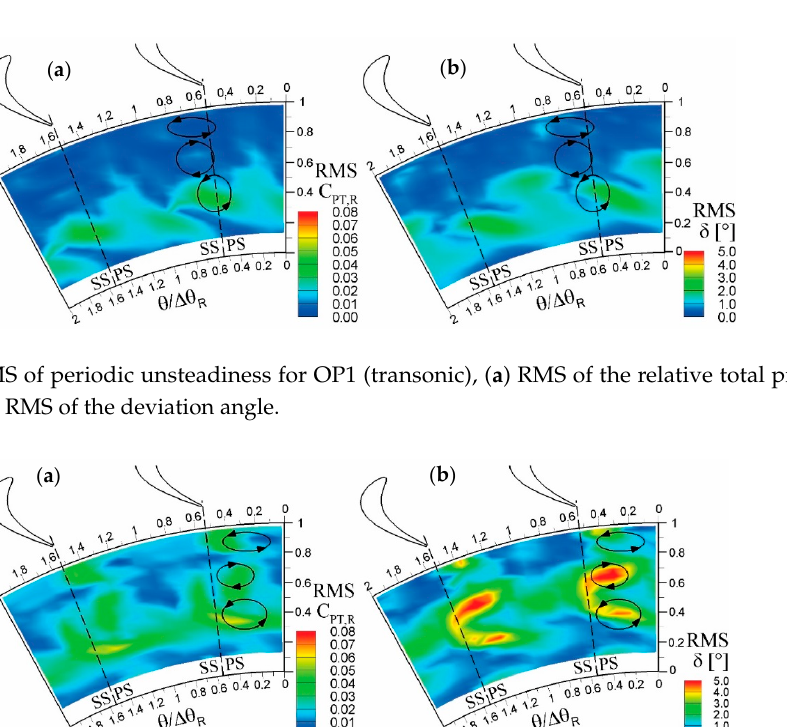
Table 5. Stage efficiency and stator total pressure loss for all the tested operating conditions.